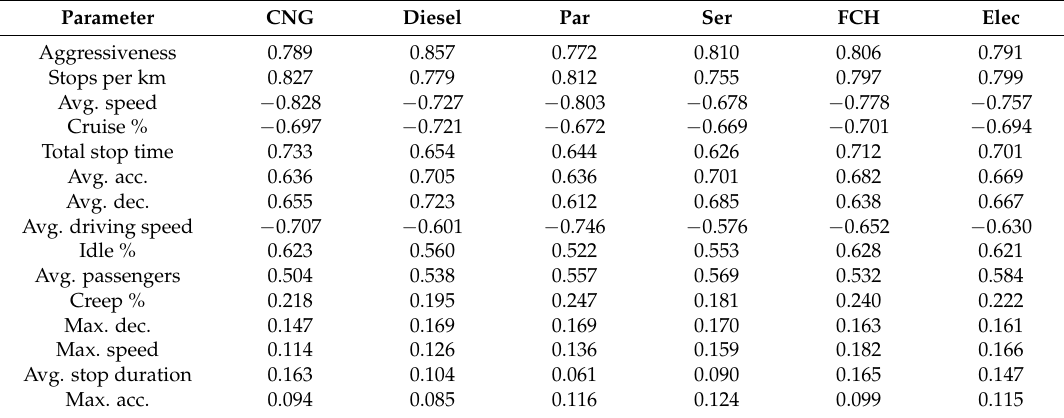
Table 10. Pearson correlation coefficients for cycle parameters and energy consumption on the synthetic